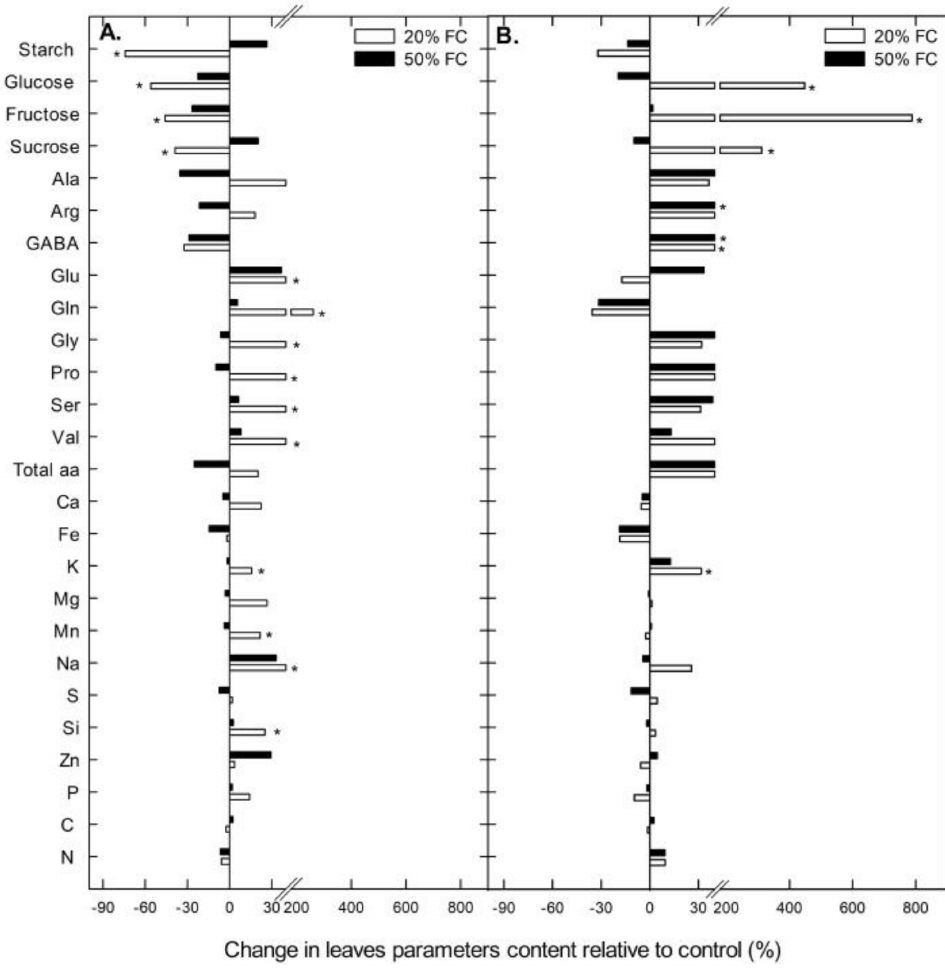
Figure 4. Change in carbohydrates, amino acids and mineral contents relative to control (%) in leaves of two quinoa cultivars (Rainbow – A and Illpa – B ) grown under irrigation regimes of 100% substrate holding full capacity (FC), 50% FC or 20% FC. The asterisks indicate significant di ff erences with p < 0.05 of treatment relative to control ( n =